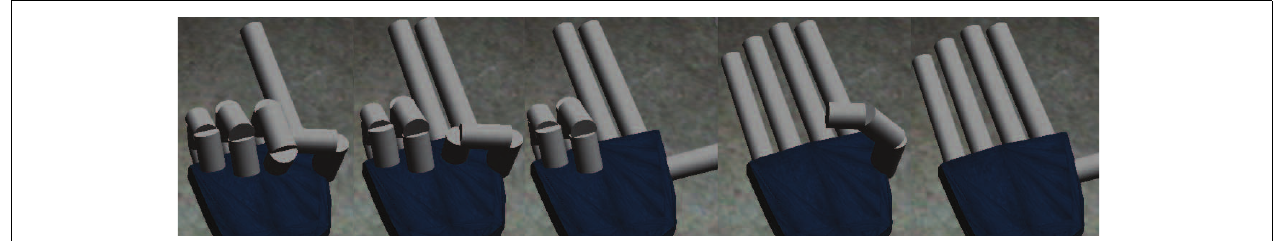
FIGURE 1 | Number representation with the right hand fingers of the iCub. From left to right: one, two, three, four and